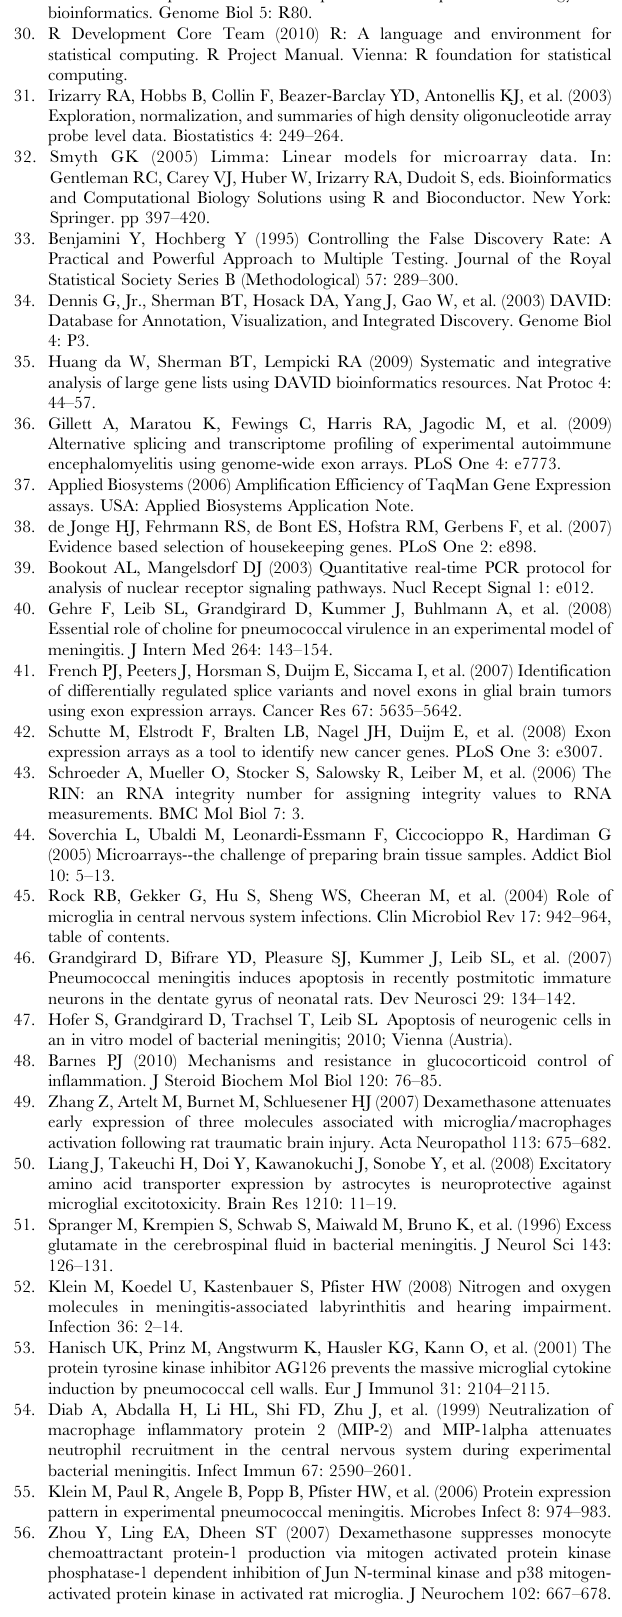
activated protein kinase in activated rat microglia. J Neurochem 102: